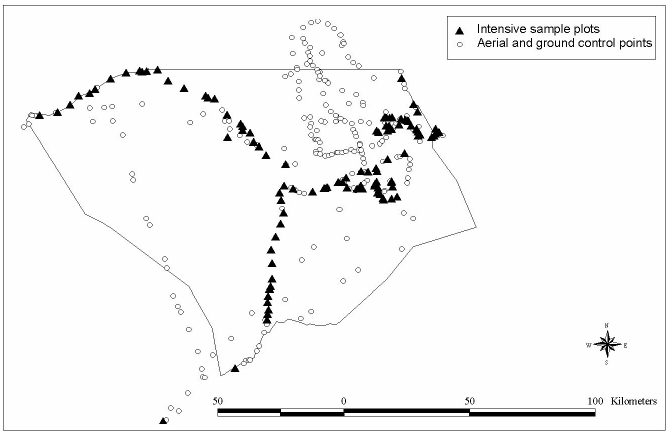
Fig. 3. Position of vegetation sample plots and control points in the Parque Nacional de